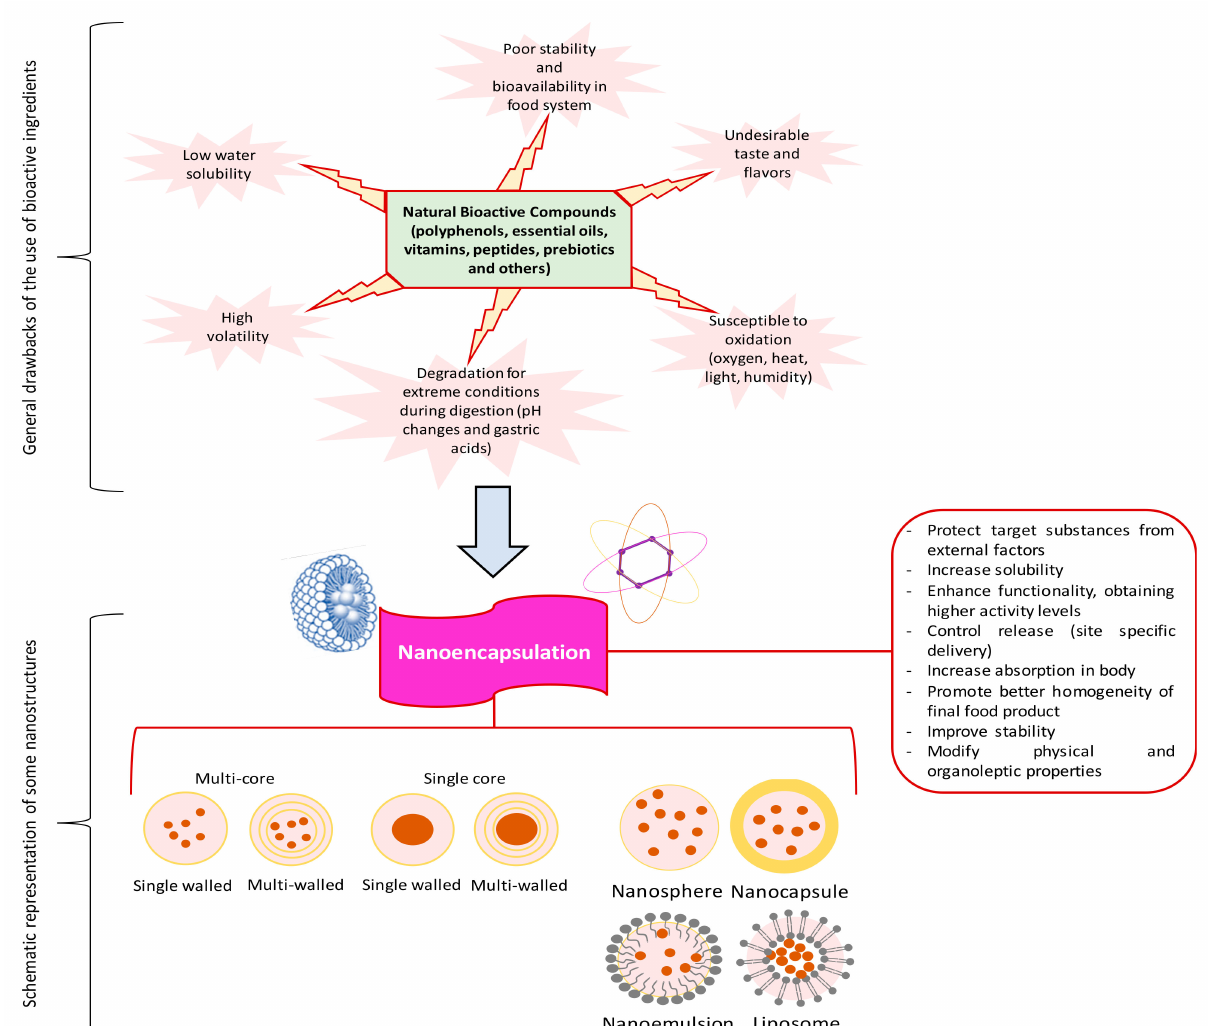
Figure 1. Limitations of the use of bioactive compounds (BACs) in the food industry and advantages of nanoencapsulation to enhance their